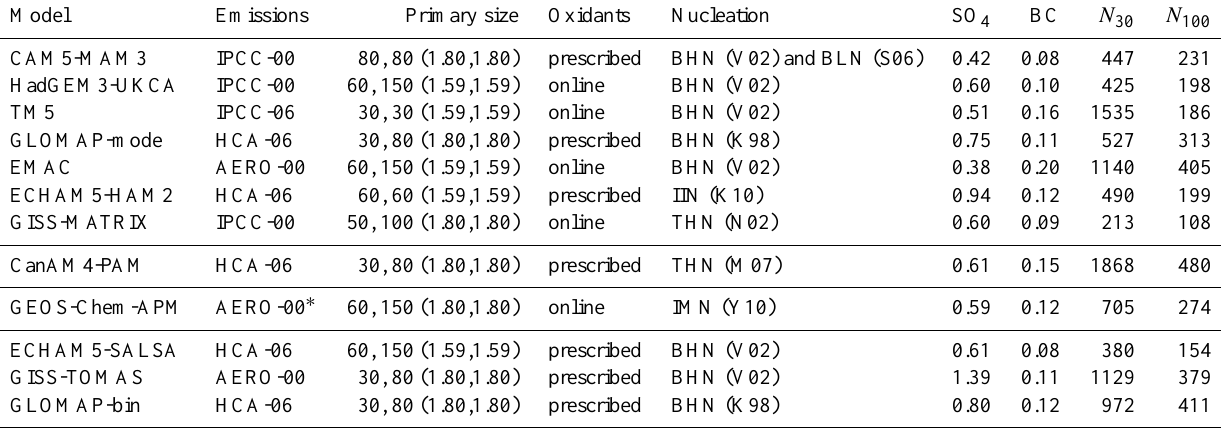
∗ Except for anthropogenic SO 2 and NO x which is based on the Emissions Database for Global Atmospheric Research (EDGAR) inventory (Olivier and Berdowski, 2001) and scaled to year 2006 with also some improved estimates from other inventories for several regions (G. Luo, personal communication,